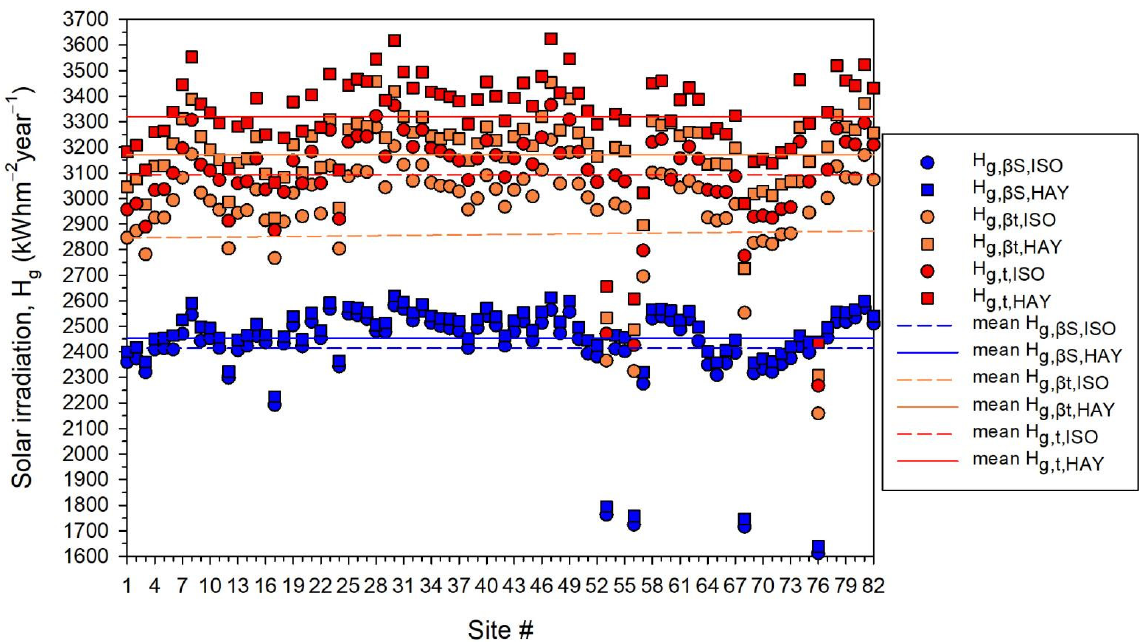
Figure 3. Variation in the annual solar energy yields across the 82 sites of Saudi Arabia and averaged over the period 2005–2016 under all-sky conditions. The modelled variation is shown for the 3 solar system configuration modes and both ISO- and HAY-modelled results. The horizontal lines are the averages of the yields over all sites: the short-dashed ones indicate the ISO model and the solid lines the HAY model.